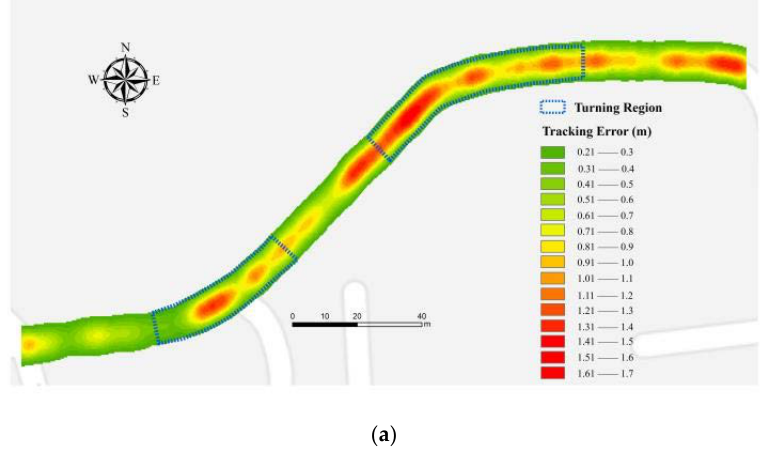
Figure 12. Comparison of CDF localization error between different learning-by-example (LBE) algorithms.